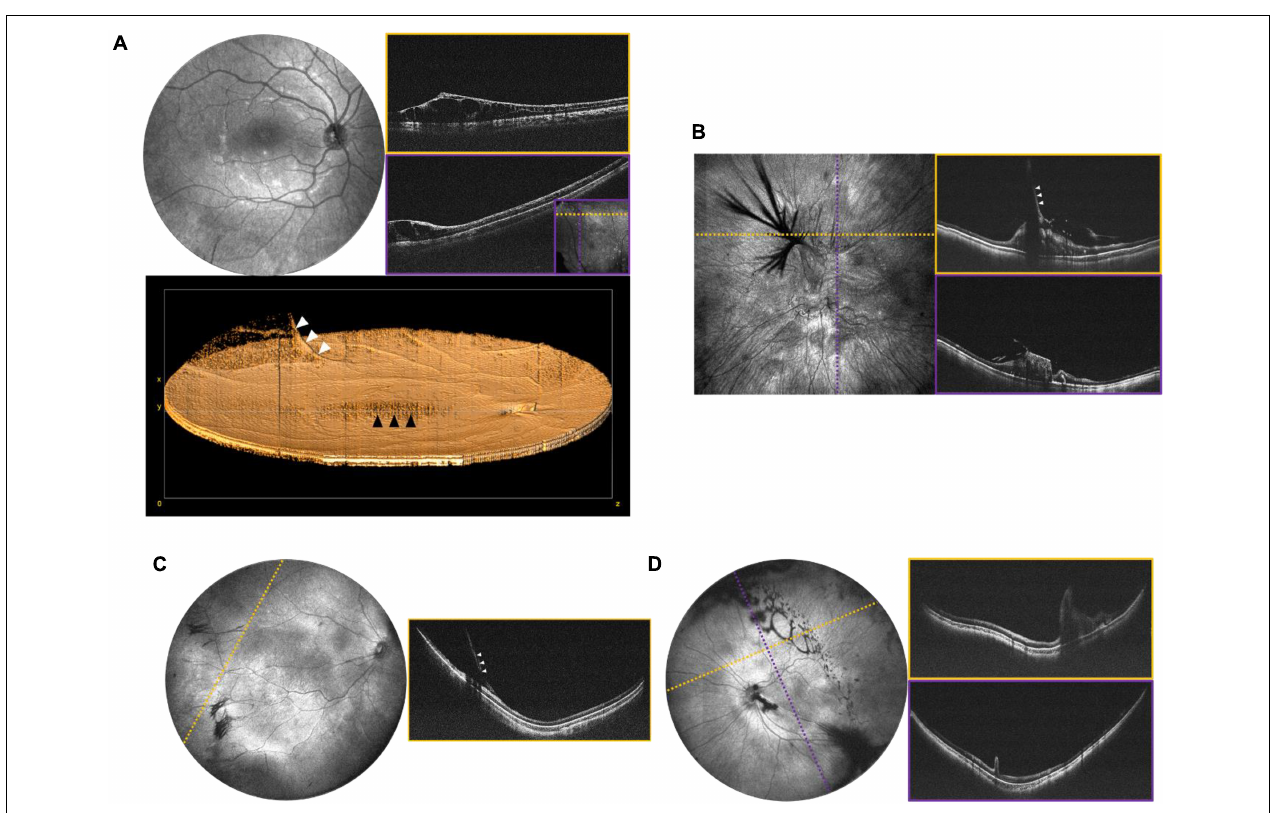
FIGURE 7 | Peripheral retinal and vitreoretinal interface abnormalities. (A) OCT evaluation in an 8-year-old patient with XLRS. Top left shows the 55 ◦ FOV en face projection, with corresponding volume rendering shown below. White arrows denote a blood vessel extending into the area of vitreoschisis (vitreous veils) and black arrows denote the area of foveoschisis. Top right images show high-resolution scans of an area of retinoschisis taken with 40 ◦ FOV. The inset in the bottom-right corner of the purple B-scan shows the locations of the cross-sections in dotted lines. (B) OCT evaluation of 7-month-old patient with history of non-accidental trauma, displaying disorganization of the retinal architecture, as well as vitreoretinal traction in region of prior breakthrough vitreous hemorrhage. Left image shows a 40 ◦ FOV en face projection, with dashed yellow and purple lines denoting the location of the corresponding B-scans on the right. White arrows denote vitreoretinal traction. (C) Vitreoretinal traction in a 2-month-old at site of regressed stage 3 extraretinal neovascularization in ROP. Left image shows 105 ◦ FOV en face view with dashed line indicating the location of the cross-sectional B-scan pictured on the right. White arrows denote vitreoretinal traction. (D) 1-month-old with ectopic PFV. Top left image shows the 105 ◦ FOV en face projection with complex oval-shaped vitreoschisis. Dotted lines correspond to B-scan locations demonstrating retinal fold through the